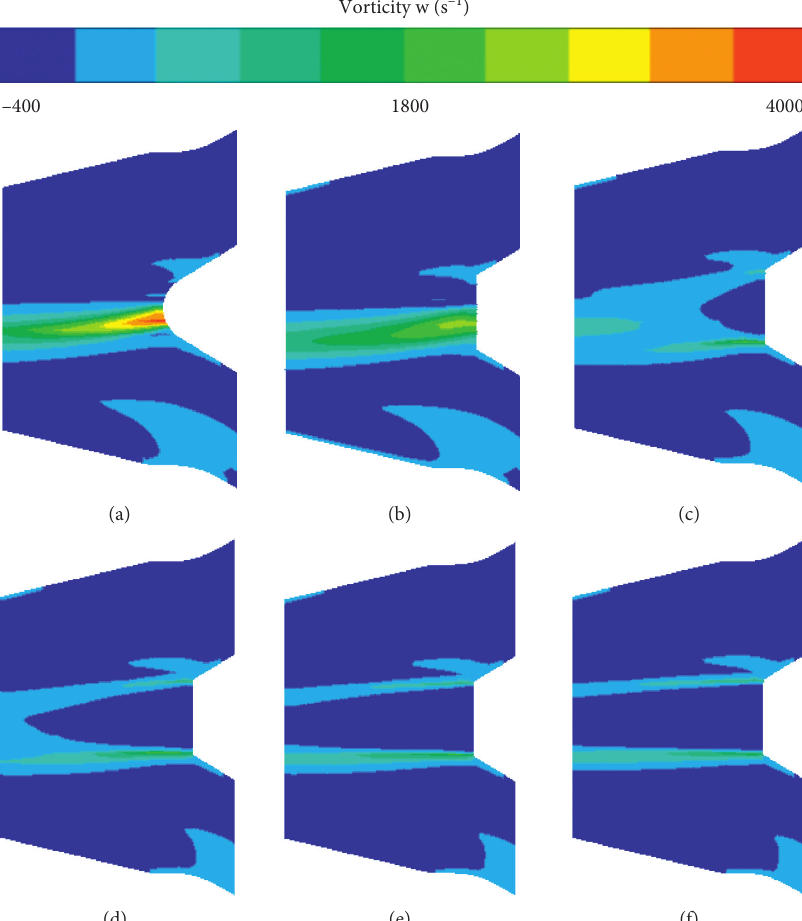
Figure 14: Vortex distribution cloud diagram of the longitudinal section of the nozzle section. (a) Original device, (b) v � 8, (e) v � 12, (f) v � 16 (m s − 1 (d) v jet jet jet